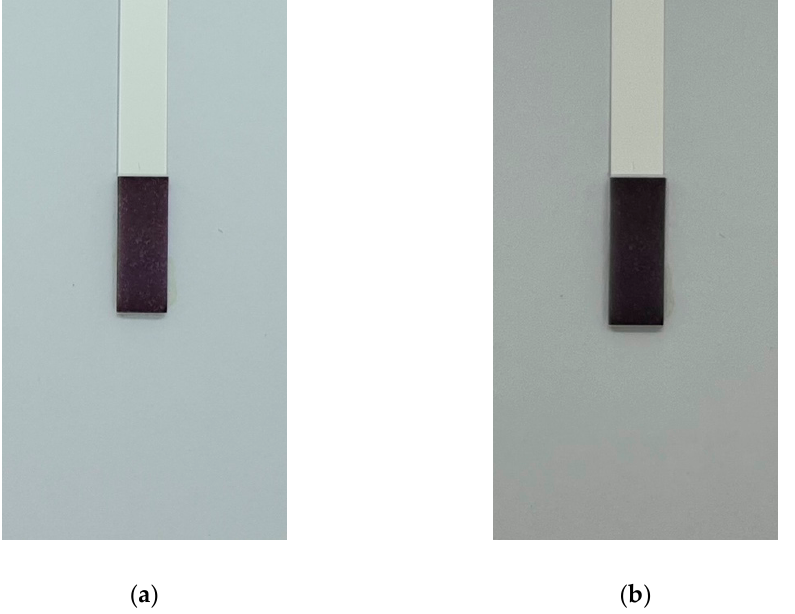
Figure 8. The MTT-PMS test strips for 10 8 CFU/mL E. coli following a 20-min incubation under: ( a ) Samsung Galaxy Note 9; ( b ) iPhone 13.